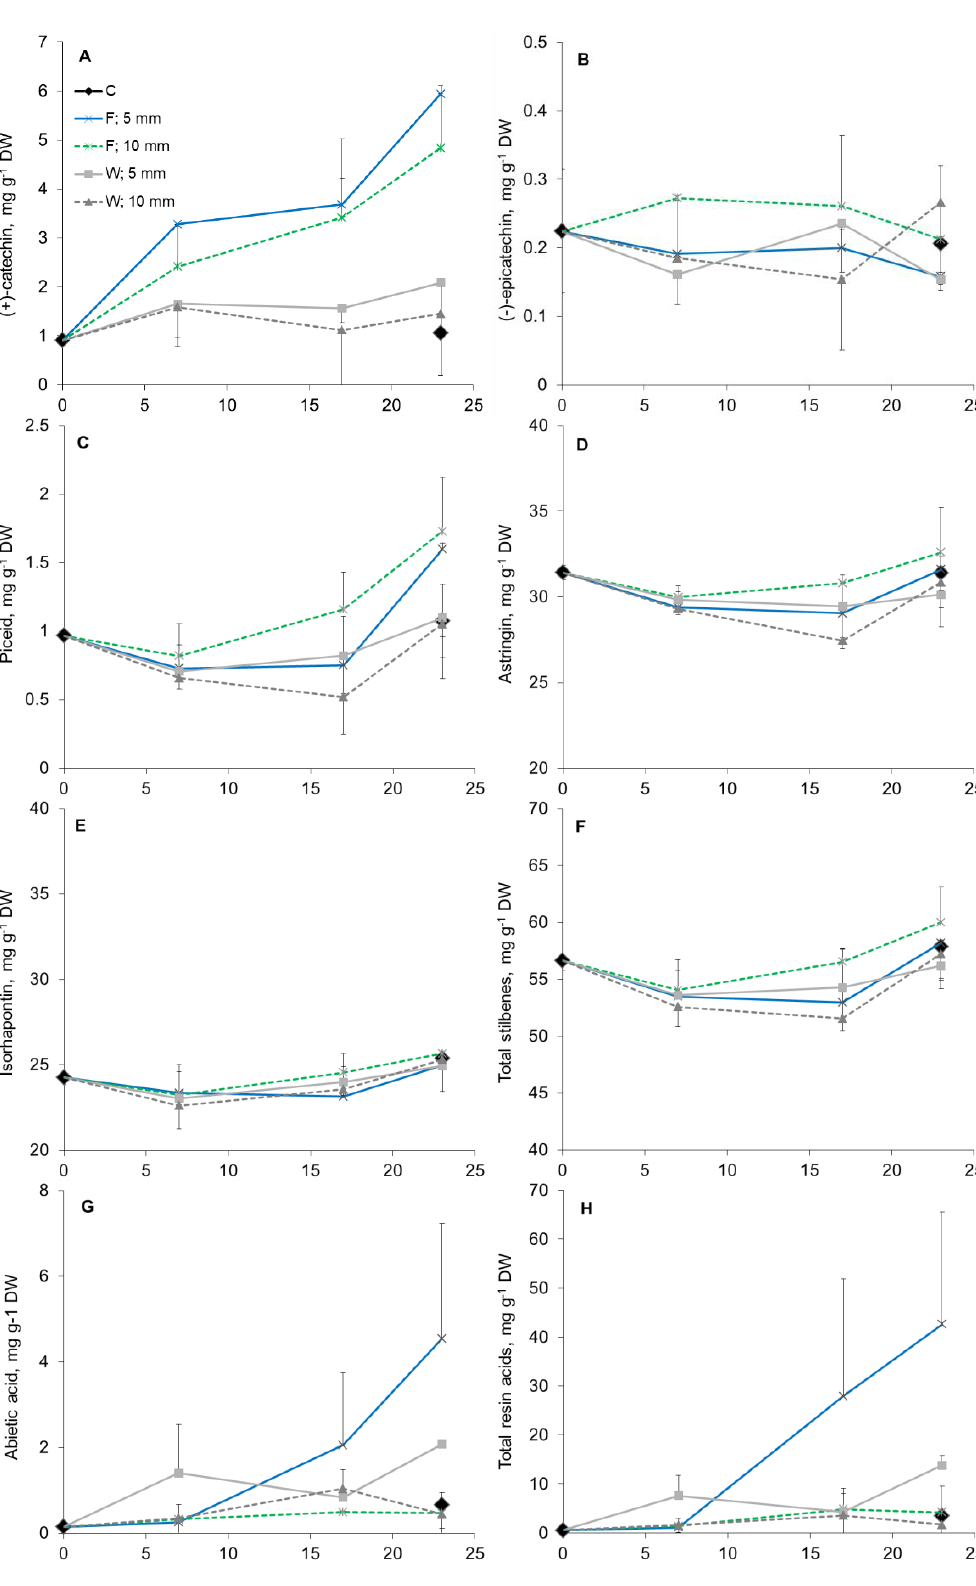
Figure 7. Amounts of ( + )-catechin ( A ), ( − )-epicatechin ( B ), stilbene glucosides piceid ( C ), astringin ( D ), isorhapontin ( E ), total stilbenes ( F ), abietic acid ( G ), and total resin acids (H) in the phloem and bark of Norway spruce saplings during the 23-day period after treatment onset, as analyzed by GC-MS. The treatments were: control (“C”), wounding (“W”), and inoculation with fungi (“F”). Samples were at 5 and 10 mm from the treated location (wound/inoculation).